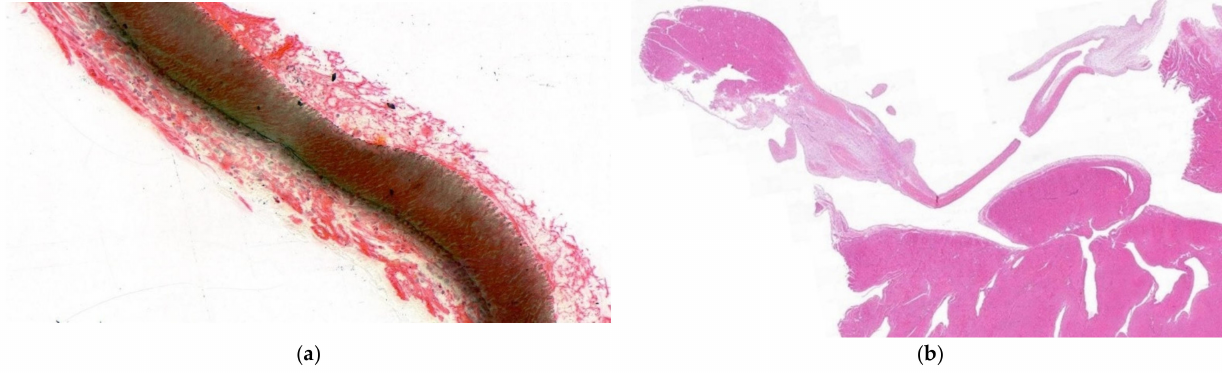
Figure 5. Pathology result of the opened type spacer. ( a ) The spacer is not completely sealed and partially opened; the resulting in neointima covers outside and inside the ePTFE coating. ( b ) The leaflet generally shows no symptoms of damage. There is a slight thickening in the edge of the anterior leaflet, which is expected to be a device contact—no noticeable foreign body